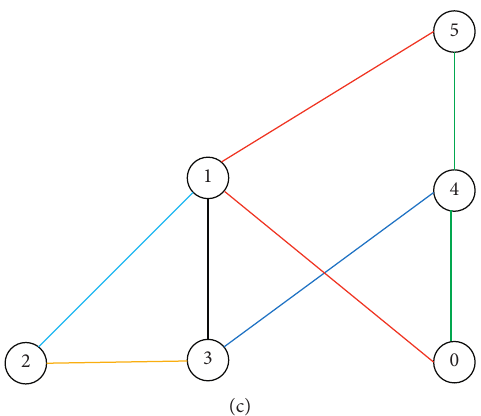
Figure 3: Line graph of G and classification of the edge sets into equivalence classes for the graphs in Figure 1. (a) G 1 . (b) G 2 . (c) G 3 1